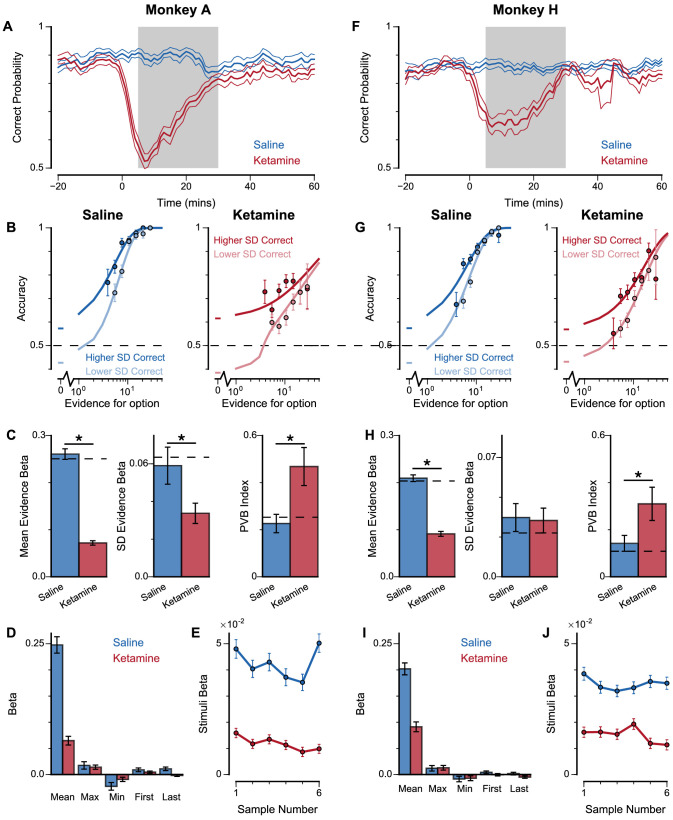
Extra information on ketamine experiments, separated by subjects.(A) Mean percentage of correct choices across sessions made by Monkey A relative to the injection of ketamine (red) or saline (blue). (B) The psychometric function of Monkey A when either the ‘Lower SD’ or ‘Higher SD’ streams are correct with saline (left) or ketamine (right) injection. (C) Ketamine injection impairs the behaviour of Monkey A, in a manner consistent with the prediction of the lowered E/I circuit model. Dashed lines indicate pre-injection values in each plot. (Left) The regression coefficient for mean evidence, under injection of saline or ketamine. Ketamine significantly reduces the coefficient (permutation test p<1×10−6), reflecting a drop in choice accuracy. (Middle) The regression coefficient for evidence standard deviation, under injection of saline or ketamine. Ketamine significantly reduces the coefficient (permutation test p=4.98×10−3), but to a lesser extent than that of the mean evidence regression coefficient. (Right) Ketamine increases the PVB index (permutation test p=1.16×10−3), consistent with the model prediction of the lowered E/I circuit. (D) The regression model using mean, maximum, minimum, first, and last evidence values of each of the left and right streams as regressors, under injection of saline or ketamine. Each bar shows the average of the left and right regressors of the corresponding variable. Ketamine injection does not alter decision-making strategies. (E) The regression weights of stimuli at different time-steps, for Monkey A with saline or ketamine injection. Ketamine injection lowers and flattens the curve of temporal weights, consistent with the lowered E/I circuit model. (F–J) Same as (A–E) but for Monkey H. (H) Ketamine significantly reduces the regression coefficient for mean evidence (permutation test p<1×10−6), does not significantly reduce the regression coefficient for evidence standard deviation (permutation test p=0.871), and significantly increases the PVB index (permutation test p=5.92×10−3). All errorbars indicate the standard error.